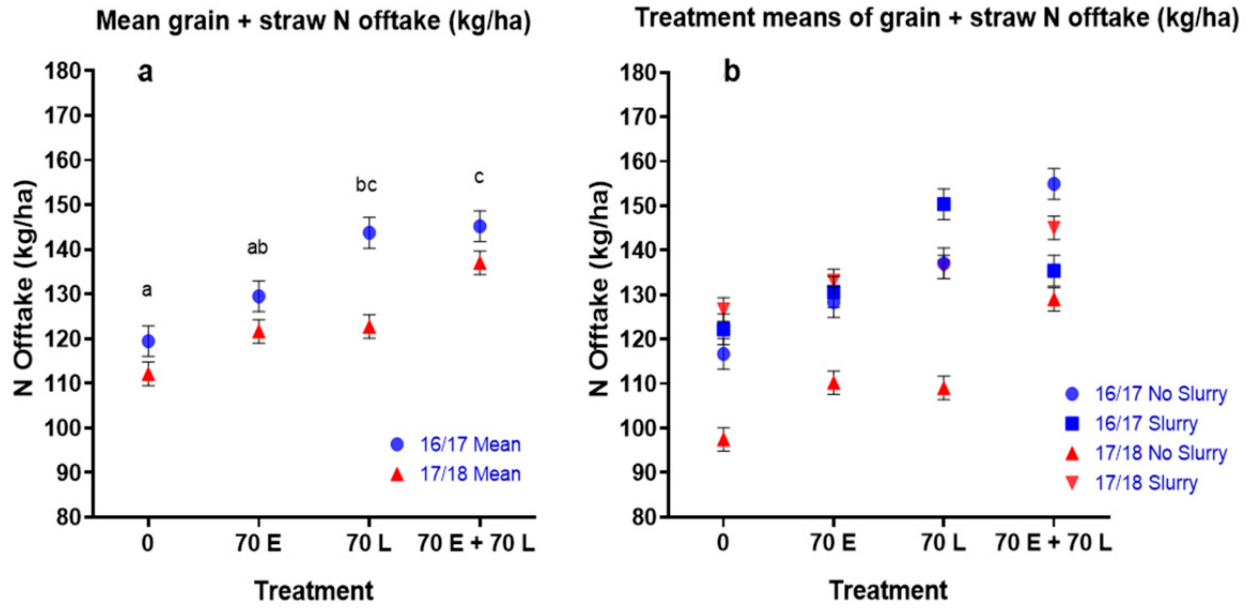
Figure 4. Total N offtake including grain and straw (kg/ha). Error bars represent standard error of the mean (SEM). Different letters show statistical differences between treatments determined by Fisher’s protected LSD (0.05). Table 10. 2016/17 REML analysis total N offtake (kg/ha).